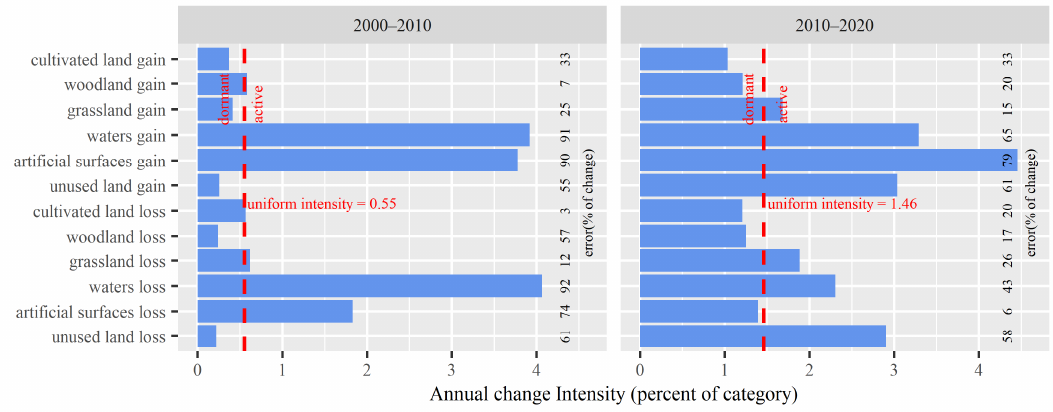
Figure 6. Category level gain and loss intensities through two time intervals for the middle reaches of the YRB.